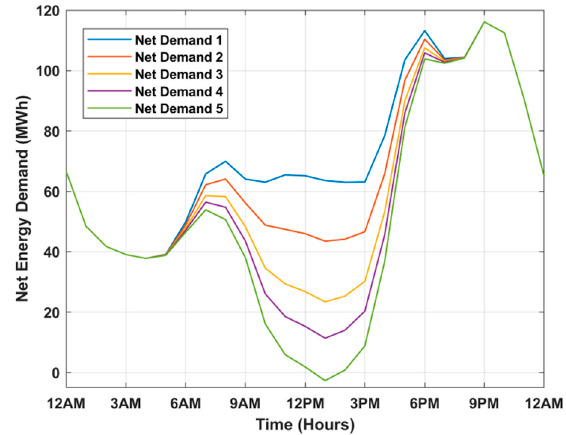
Figure 6. Net energy demand at different levels of solar penetration.